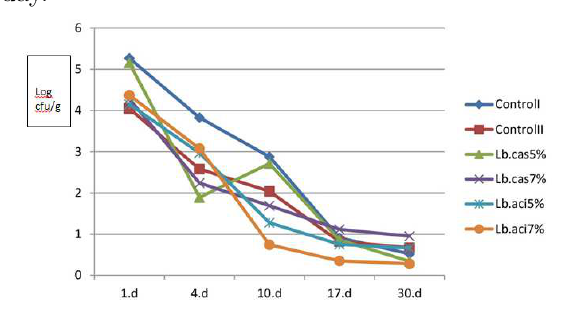
Figure 4. Total yeast numbers (log CFU/gr) during the storage of pick- les.